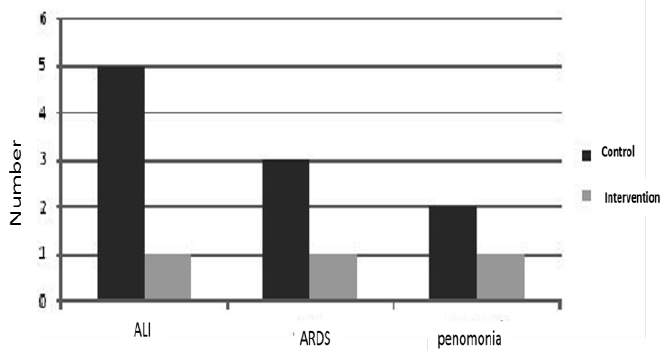
Figure 1. acute pulmonary complications in patients